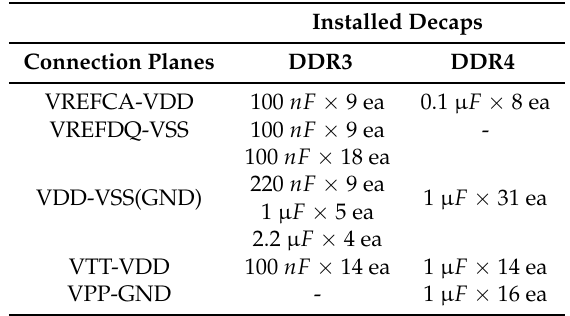
Table 6. On-SODIMM board decaps installation configurations: DDR3 vs. DDR4.